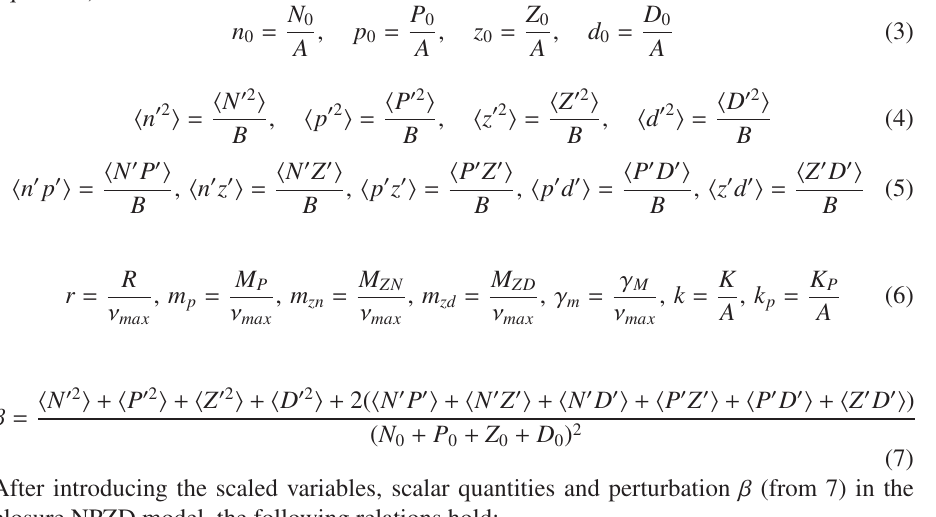
and covariance are derived. Using the following scaled variables and parameters, the devel- oped NPZD closure model transformed into the dimensionless form (reduced parameters